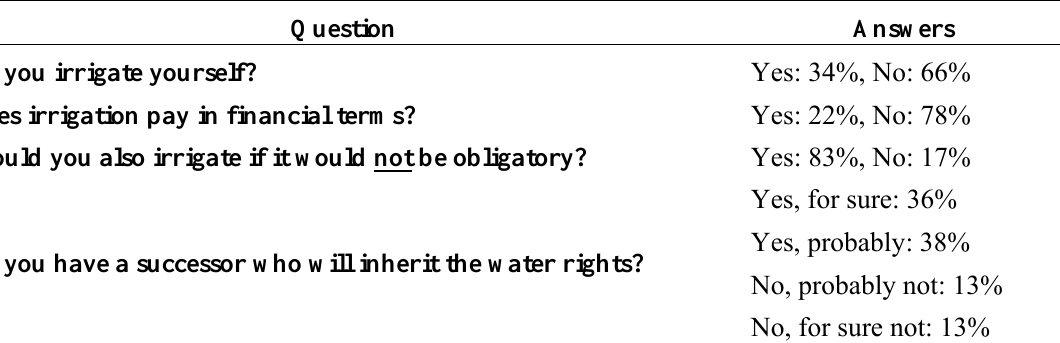
Table 3. Analysis of questions on Irrigation behavior and relevance of future